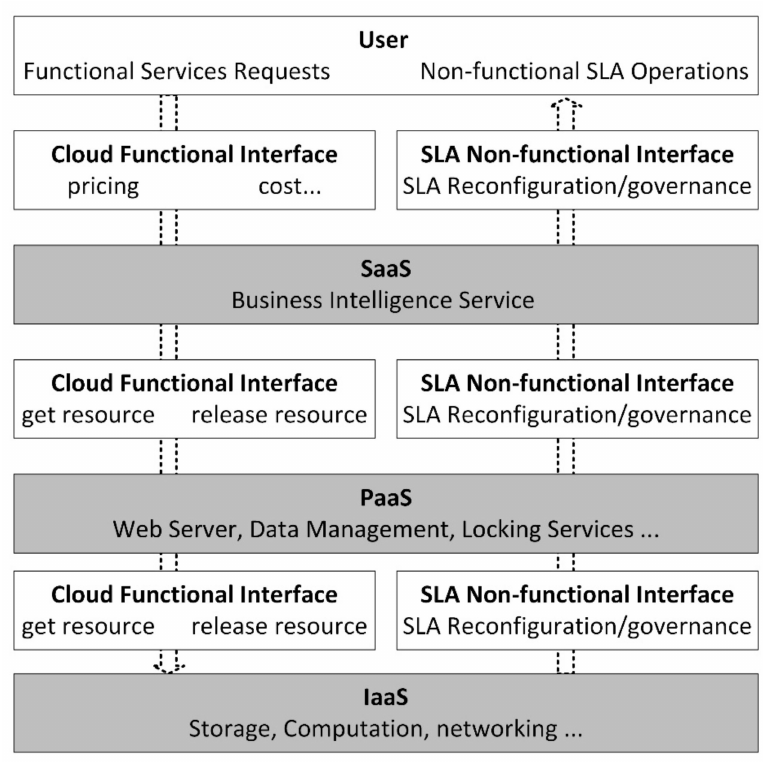
Figure 1. Model for SLA negotiation